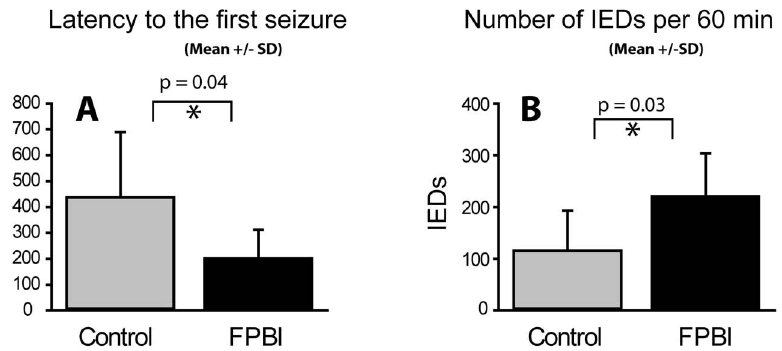
Figure 2. (A) Latency to the first interictal epileptiform discharge (IED) and (B) Number of IEDs in rats with lateral FPI or sham-operation. Note a decrease in latency to the 1 st IED (p=0.03) and an increase in IEDs (p=0.03) in injured rats (n=7) as compared to sham-operated animals (n=6).